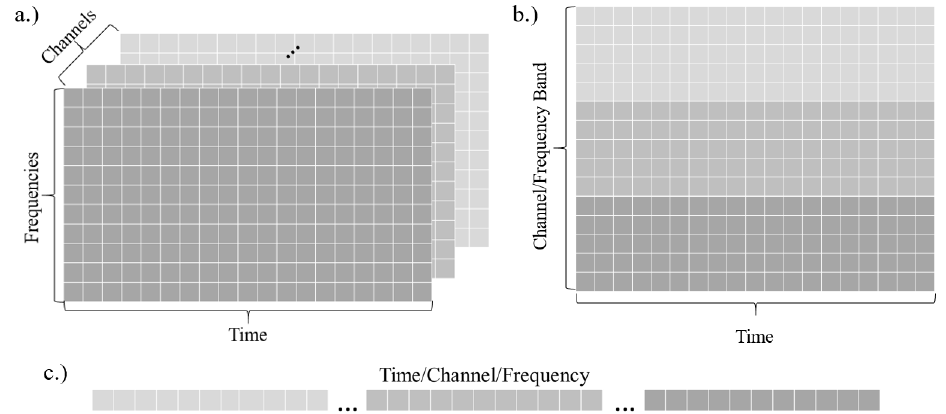
Figure 1. Input shapes for each network type are illustrated: ( a ) The CNN input shape was expanded about the channel (electrode) dimension as the number of filters increased; ( b ) The LSTM input flattened the electrode and frequency dimensions into a single combined dimension; ( c ) All dimensions were flattened into a single input vector for the